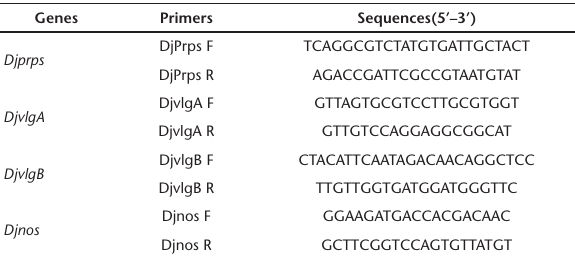
Table 1. Genes and their primer sequences used for real-time PCR